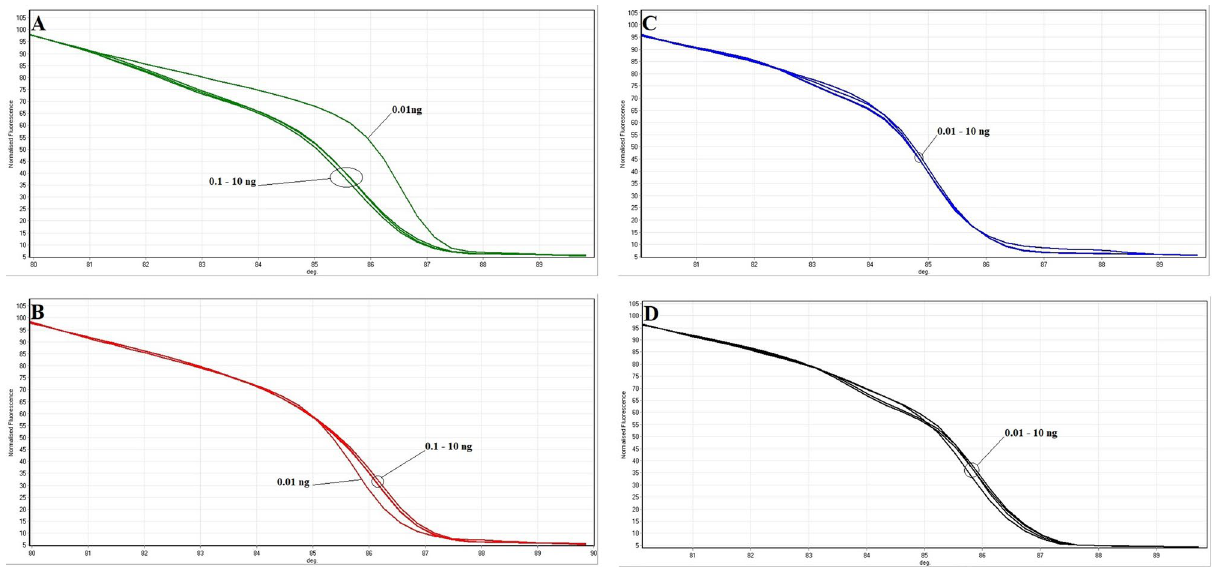
Figure 6. Normalised melting curves of DNA tenfold dilution series for ( A ) S. dysenteriae , ( B ) S. flexneri , (C) S. boydii and (D) S. sonnei .